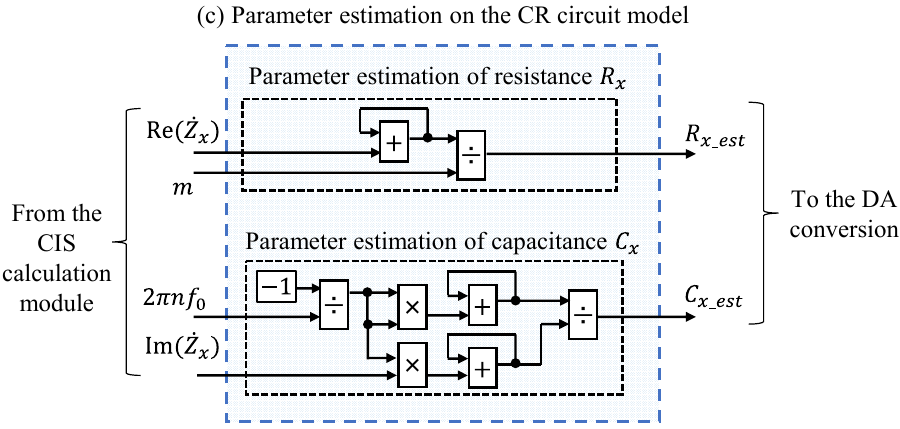
Figure 4. Detailed illustration of the parameter estimation on the CR circuit model written in Figure 1.